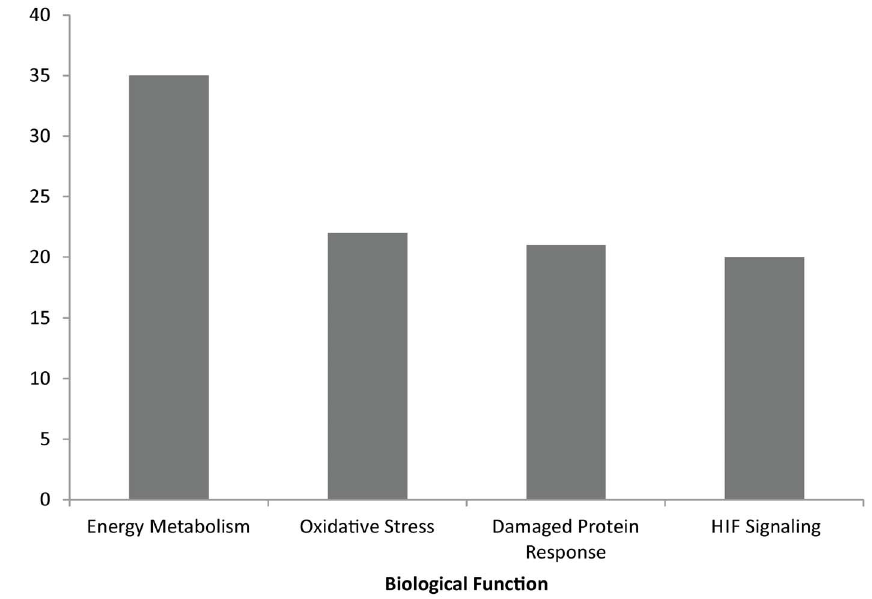
Figure 2. Overarching biological processes affected by Cobalt exposure. In order to assign function to more differentially expressed genes, we created four biological functions consistent with the enrichment analysis and literature on cobalt toxicity. The four categories are energy metabolism, oxidative stress, unfolded protein response, and HIF Signaling. A gene may be present in more than one category.